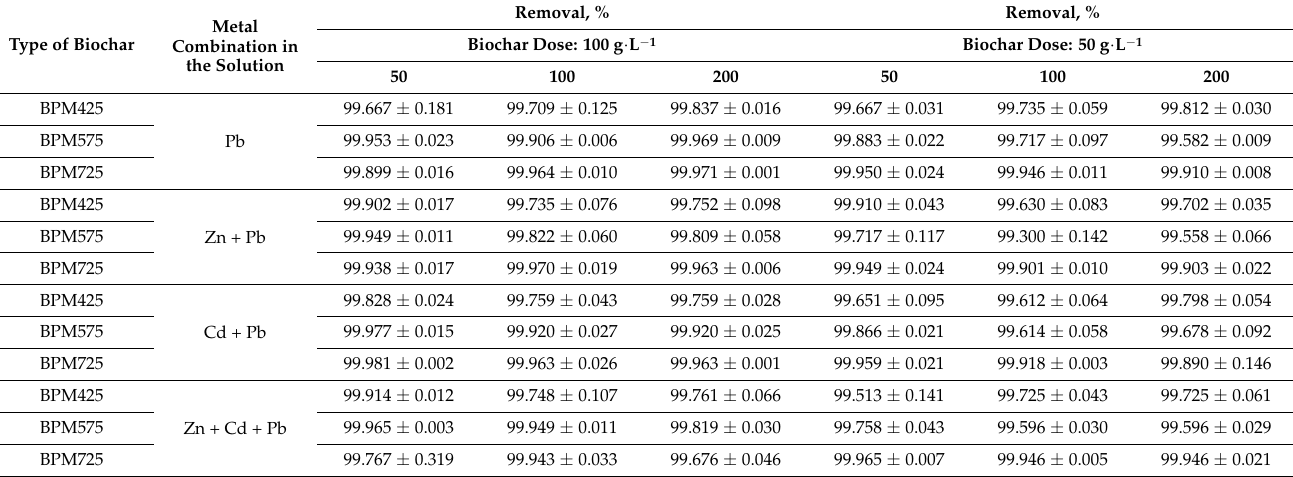
Table 10. Removal of Pb (%) from the solutions with mono-, double- and triple-metal